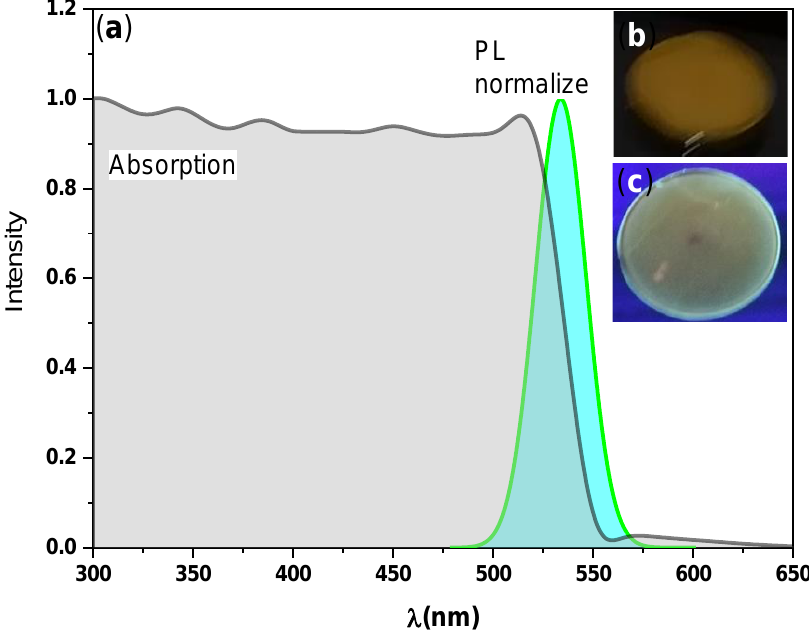
Figure 2. ( a ) UV-Visible absorption spectra and steady-state photoluminescence (PL) spectra of the CsPbBr 3 / PMMA thin disk. Insets ( b ) and ( c ) are photographs of the prepared thin-disk taken under natural and UV light, respectively, observed through an optical microscope.